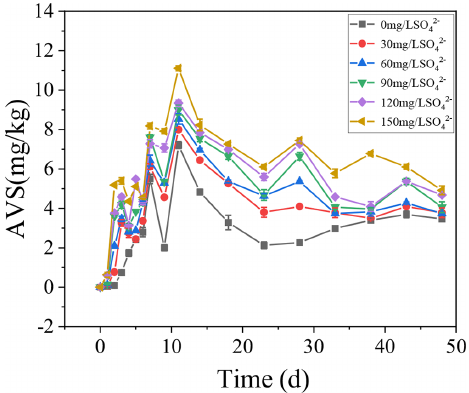
Figure 4. The concentration of AVS in the sediments during the incubation.